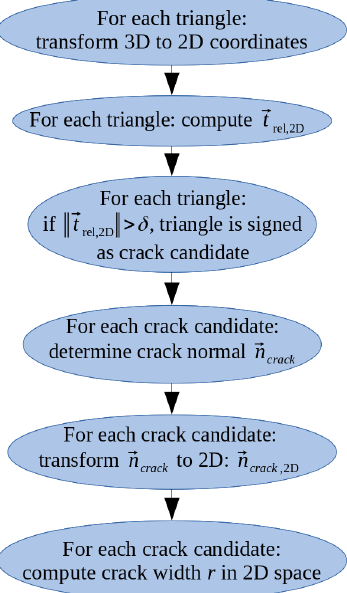
Figure 5. Flow chart of the algorithm: (cid:126)t rel is the relative translation vector. δ is a threshold. (cid:126)n crack is the crack